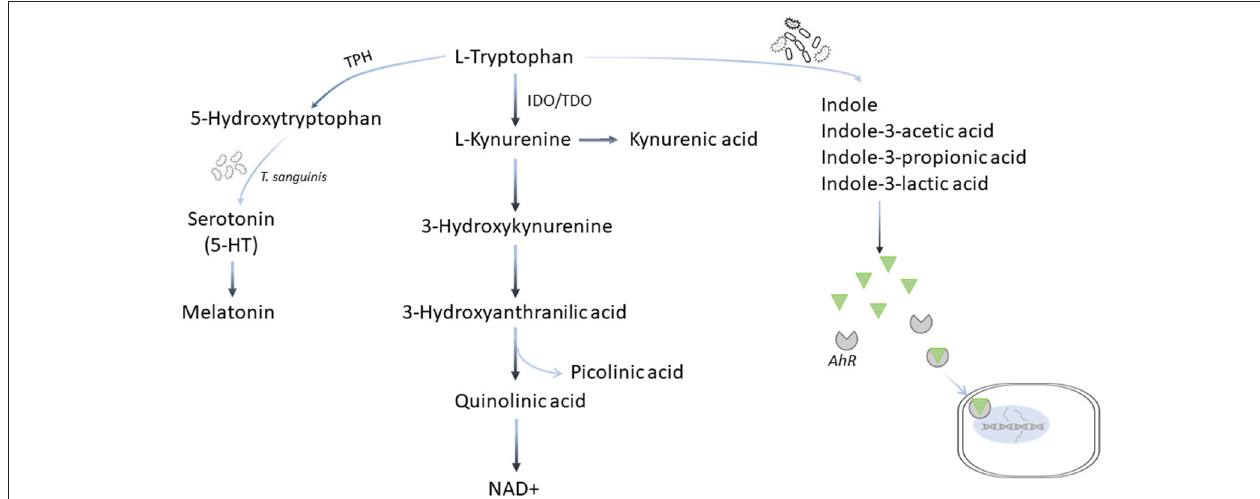
FIGURE 5 | Tryptophan metabolic pathways. Tryptophan is metabolized by three pathways. More than 90% of dietary tryptophan is metabolized via the main kynurenine pathway mediated by the indoleamine 2,3-dioxygenase (IDO) and tryptophan 2,3-deoxygenase (TDO) leading to the production of important metabolites, such as kynurenine, kynurenic acid, quinolinic acid, and eventually nicotinamide adenine dinucleotide (NAD + ), and picolinic acid; the minor serotonin (5-HT) pathway via tryptophan hydroxylase (TPH), and the third the microbiota-dependent pathways to produce several key metabolites including ligands for the aryl hydrocarbon receptor (AhR)-mediated signaling, indole and its